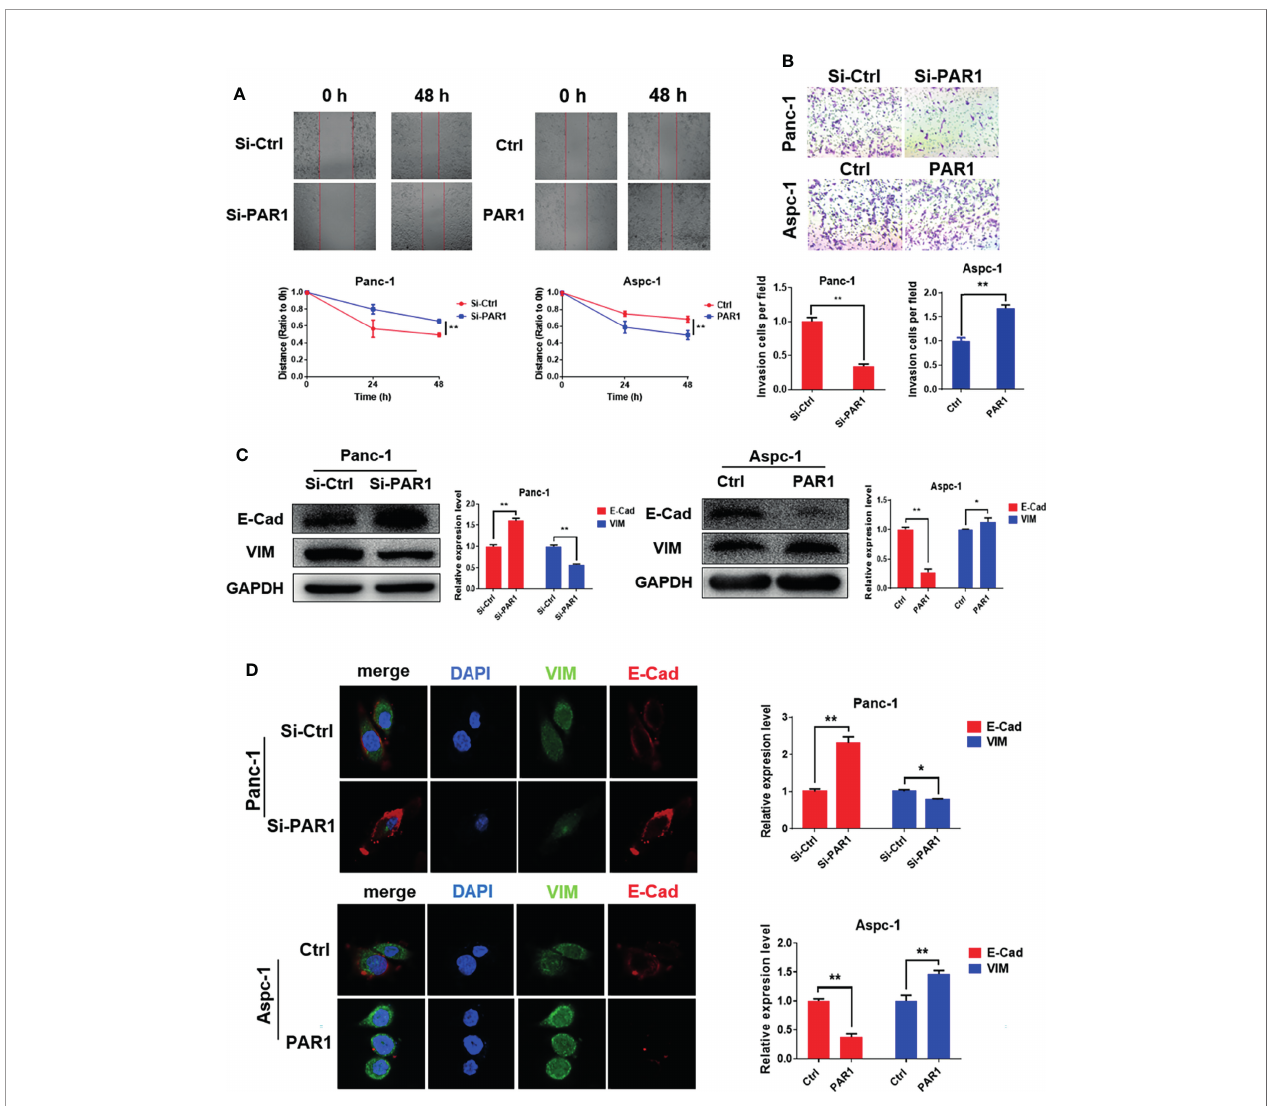
FIGURE 2 | PAR1 promotes EMT progression of pancreatic cancer cells. (A) Effect of PAR1 on Panc-1 and Aspc-1 cell migration potential detected using the wound healing assay. (B) Effect of PAR1 on pancreatic cancer cell invasion potential by using matrigel-coated transwell assay. (C) Effect of PAR1 on the E-Cad and VIM expression detected by Western blot analysis. (D) Effect of PAR1 on the E-Cad and VIM expression detected by immuno fl uorescence. Data are shown as the mean ± SD (* P < 0.05, ** P <